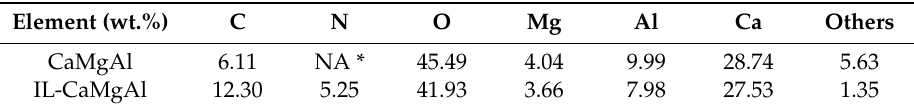
Table 2. Surface element content of CaMgAl and IL-CaMgAl.